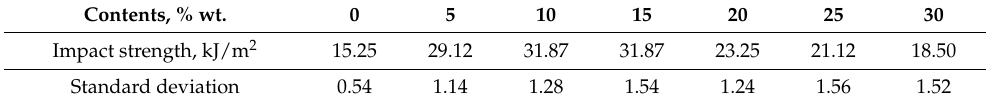
Table 7. Impact strength depending on the content of the content of the Crusil M20 filler. Contents, % wt.